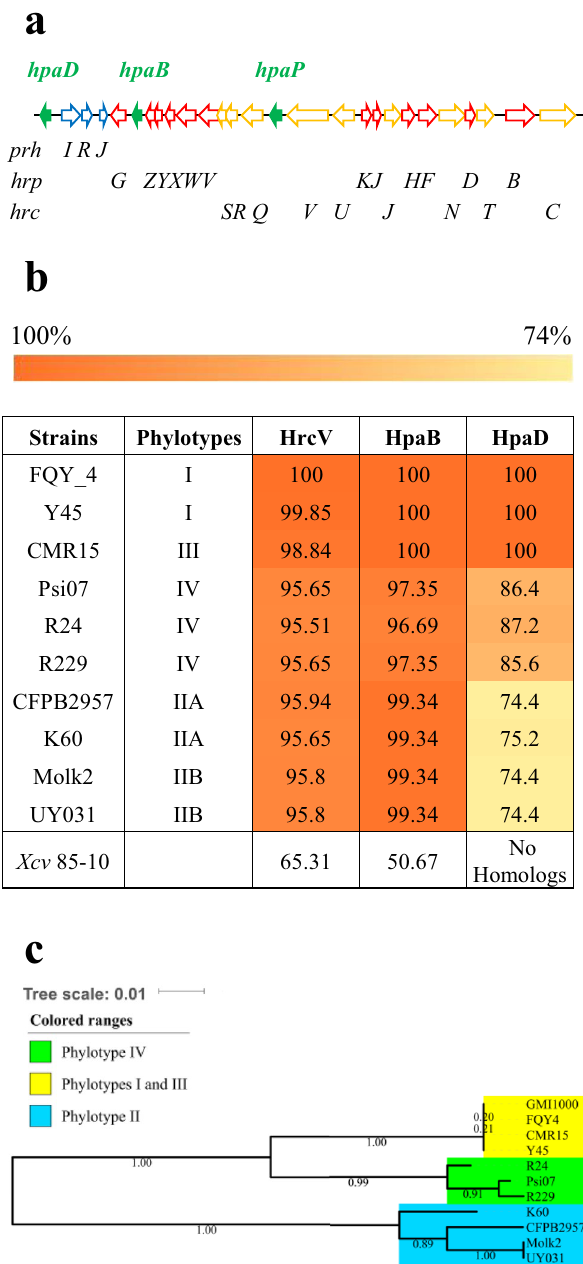
Figure 1. HpaB and HpaD: two putative type III chaperones, encoded by genes located on the hrp gene cluster, are conserved among all the four phylotypes of the R . solanacearum species complex (RSSC). ( a ) Schematic representation of the RSSC hrp gene cluster. The arrows represent the different genes. The green, blue, red and yellow color indicates the hpa , prh , hrp and hrc genes, respectively. ( b ) Protein identity matrix table of HrcV, HpaB and HpaD from nine RSSC sequenced strains belonging to the four phylotypes compared to the GMI1000 (phylotype I) strain. Matrix cells have been colored from orange to yellow according to the protein conservation (100% orange to 70% yellow). Xcv : Xanthomonas campestris pv. vesicatoria . ( c ) Unrooted phylogenetic tree of HpaD based on sequence similarities using the maximum likelihood method. Ten strains of RSSC were used. Bootstraps were calculated using the approximate likelihood ratio test. The phylogenic tree has been generated using MEGA